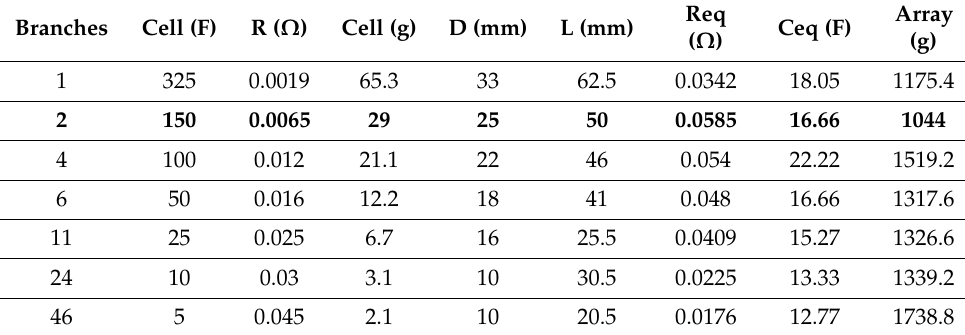
Table 7. Selection of the optimal cell. Array used highlighted in bold. Branches.